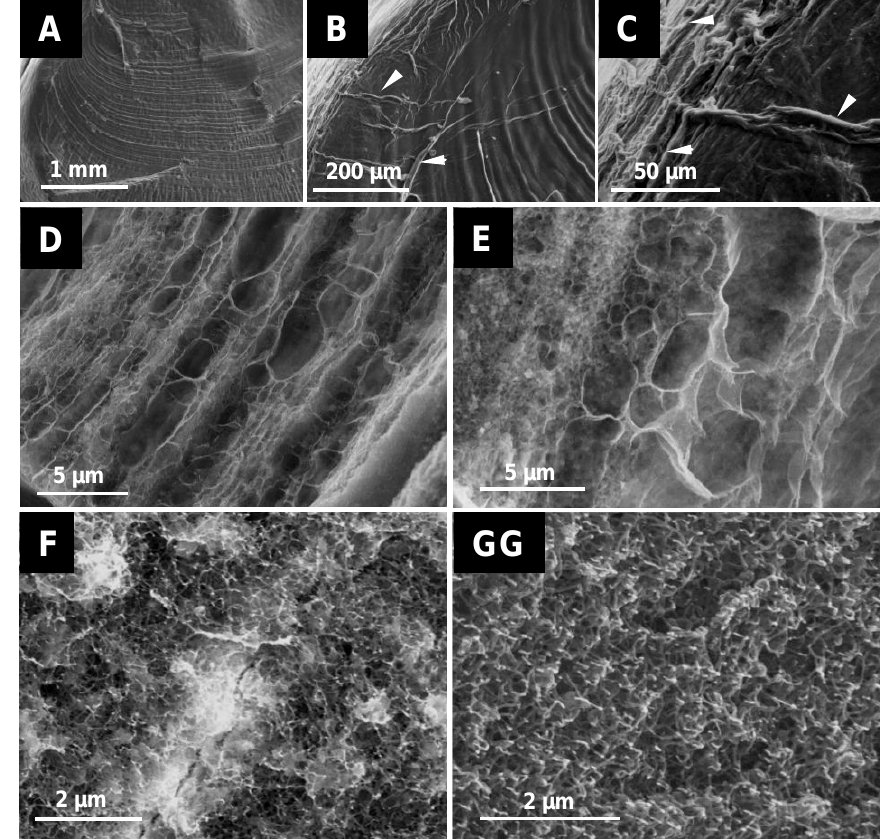
Figure 3. Structural aspect of the organic matrix of Cherax quadricarinatus gastrolith (SEM). A–C: slight surface decalcification showing the striated aspect of the gastrolith (A) and at higher magnification the presence of large fibers of organic matter (B and C; arrows heads). D–E: organic matrix fibers forming parallel layers of different widths and densities observed after surface treatment by acetic acid (partial surface decalcification). Transverse fibers are also visible resulting in a pocket-like structure. F–G: high magnifications of regions exhibiting a dense network of organic nanofibers, subdividing the previously revealed pocket-like compartments in